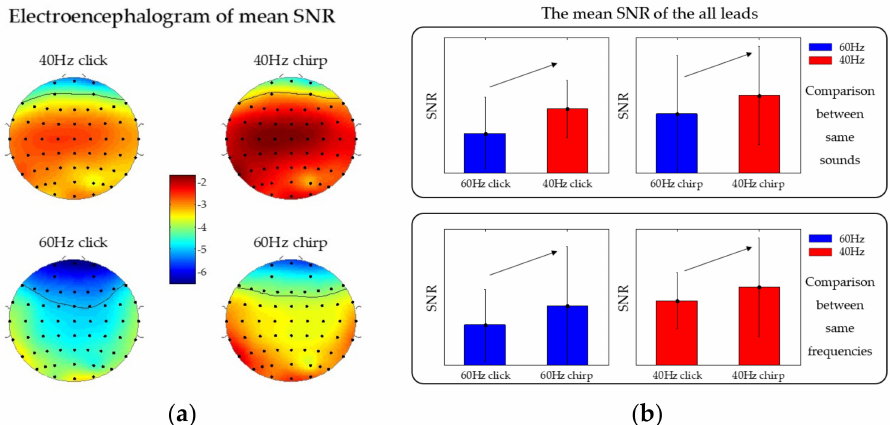
Mean signal-to-noise (SNR) electroencephalogram across 20 subjects: ( a ) 40 Hz electroencephalogram at the top and 60 Hz electroencephalogram at the bottom. The left column represents the click stimuli and the right represents chirp stimuli; ( b ) histogram of the mean SNR of ASSR under the whole